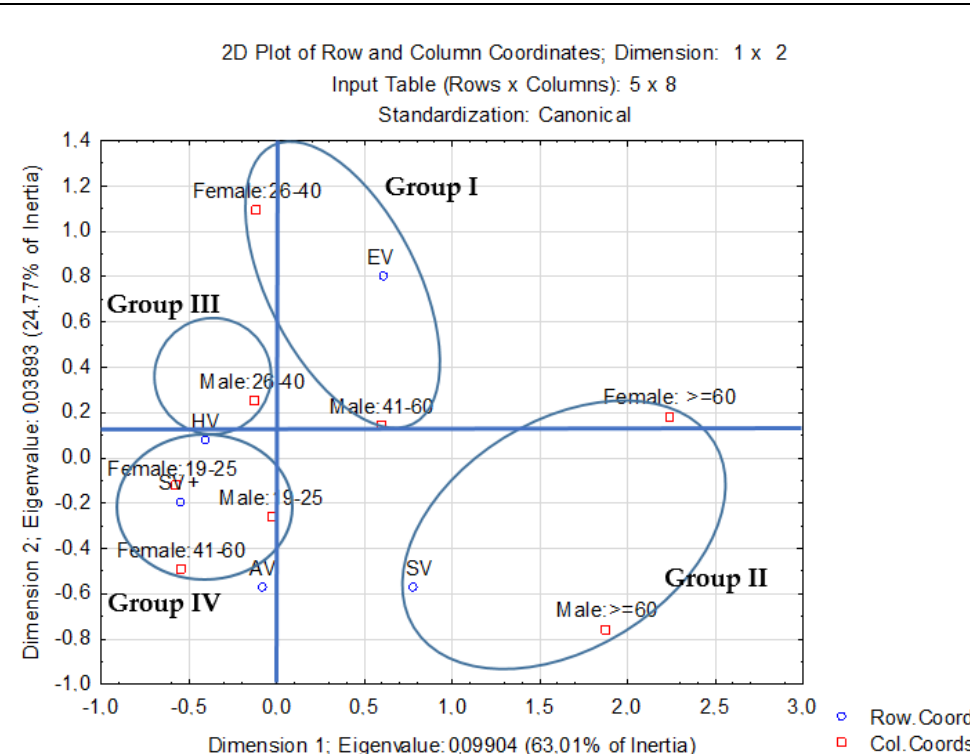
Figure 1. Correspondence analysis results between three groups of characteristics—vehicle type, age of respondents and gender.